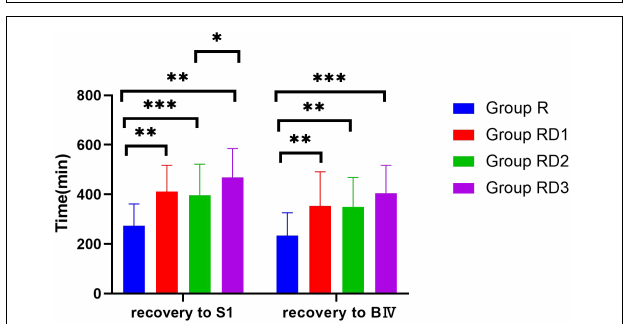
FIGURE 5 | Onset time of sensory and motor block. * p < 0.05 compared with Group R.